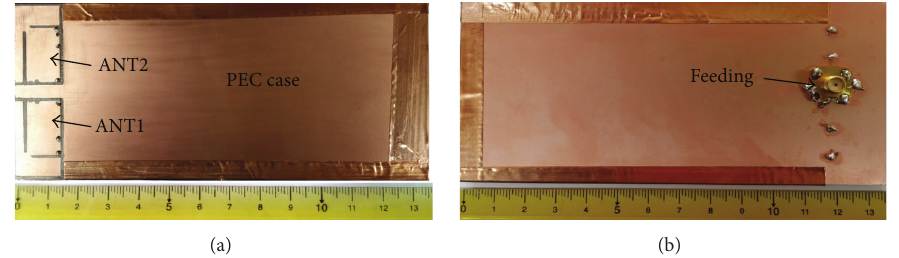
Figure 5: Fabricated antenna.